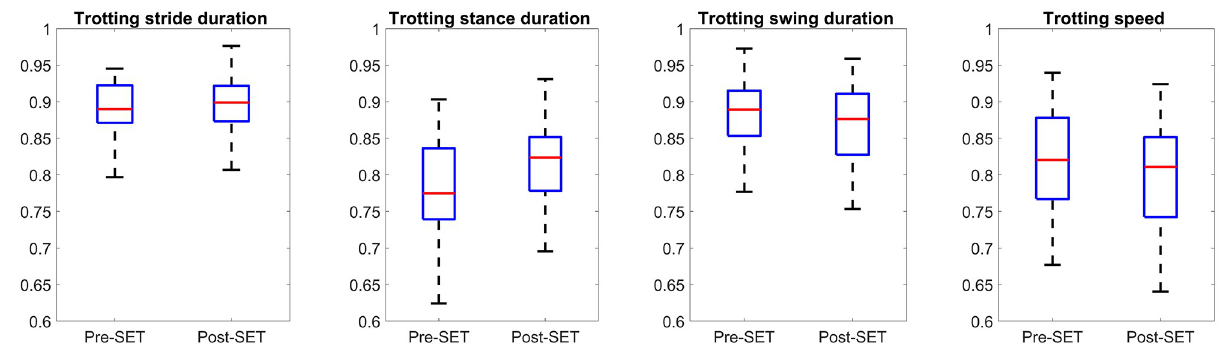
Fig 8. Comparison of speed and stride, stance, and swing duration features of all horses between pre- and post-SET during trot. The vertical axes of all plots represents the range-normalized value. The box represents the interquartile range, while the red line (horizontal line within the box) shows the median value. Each box (two for each plot) consists of one value per horse, which was averaged from all strides of the horse.